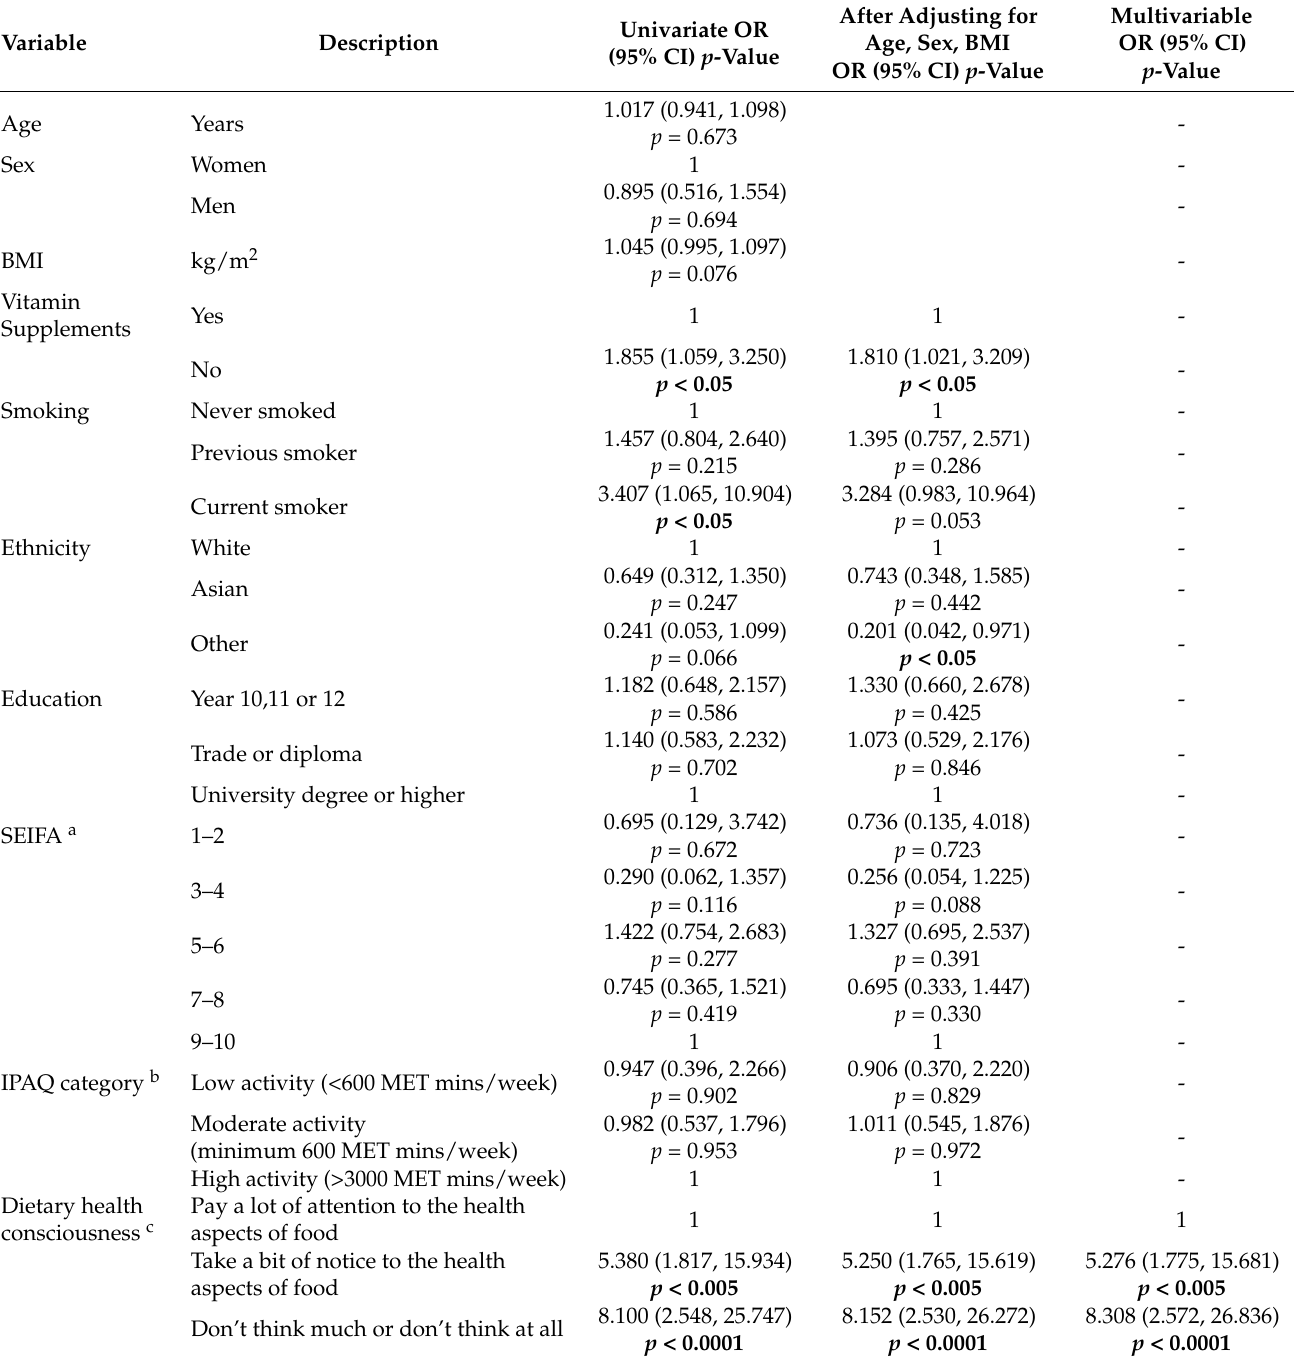
Table 5. Association between variables and the likelihood of being in the lowest tertile of HSDI scores * at baseline: Univariate; after adjusting for Age, Sex, BMI, and; Multivariable ( n =